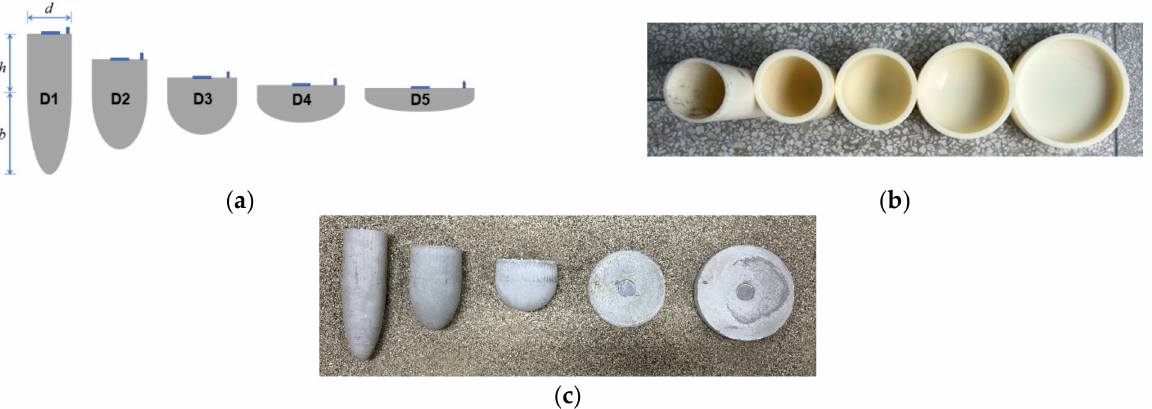
Figure 2. The production of falling stones used in laboratory experiments. ( a ) The schematic diagram of rockfall, ( b ) 3D printing mould, and ( c ) the rockfall obtained after pouring, curing, and